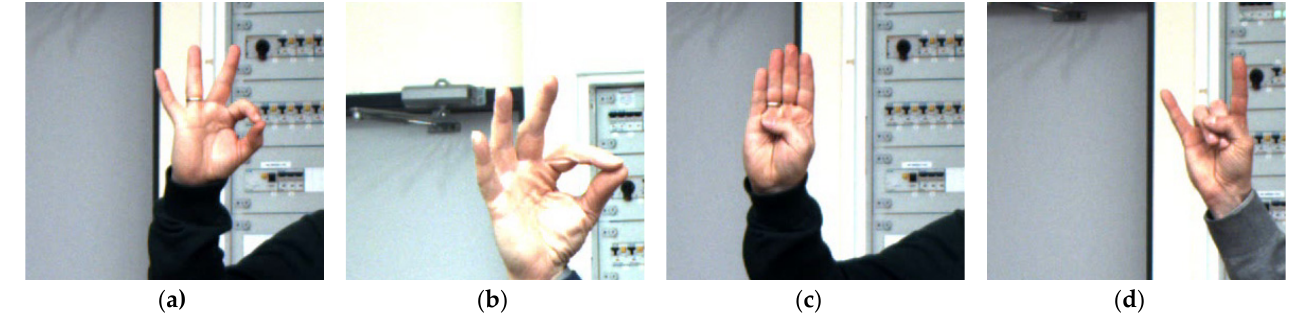
Figure 12. Rabbit(2) classi fi ed as Palm(1) ( a , b ), Stop(7) as Four(5) ( c ), Rock(6) as Victoria(3) ( d ).